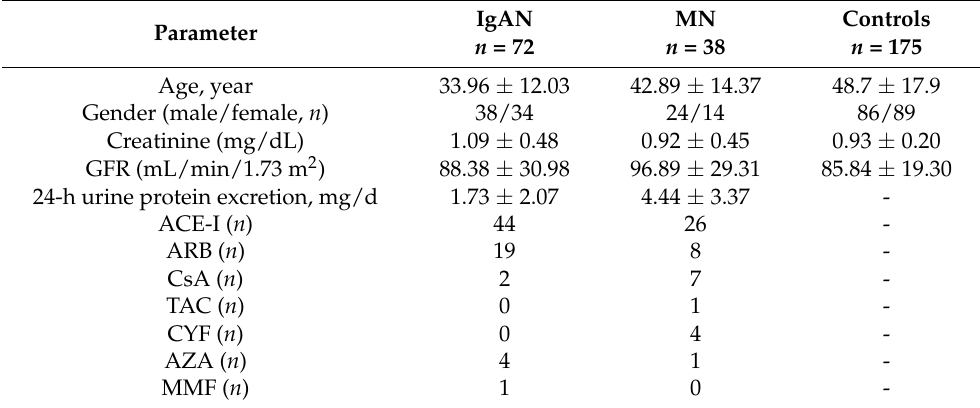
Table 1. Characteristics of IgAN and MN patients, and healthy controls. Blood samples were collected for NR3C1 polymorphism genotyping. Number of patients ( n ). ACE-I—angiotensin-converting- CYF—cyclophosphamide; MMF—mycophenolate mofetil;